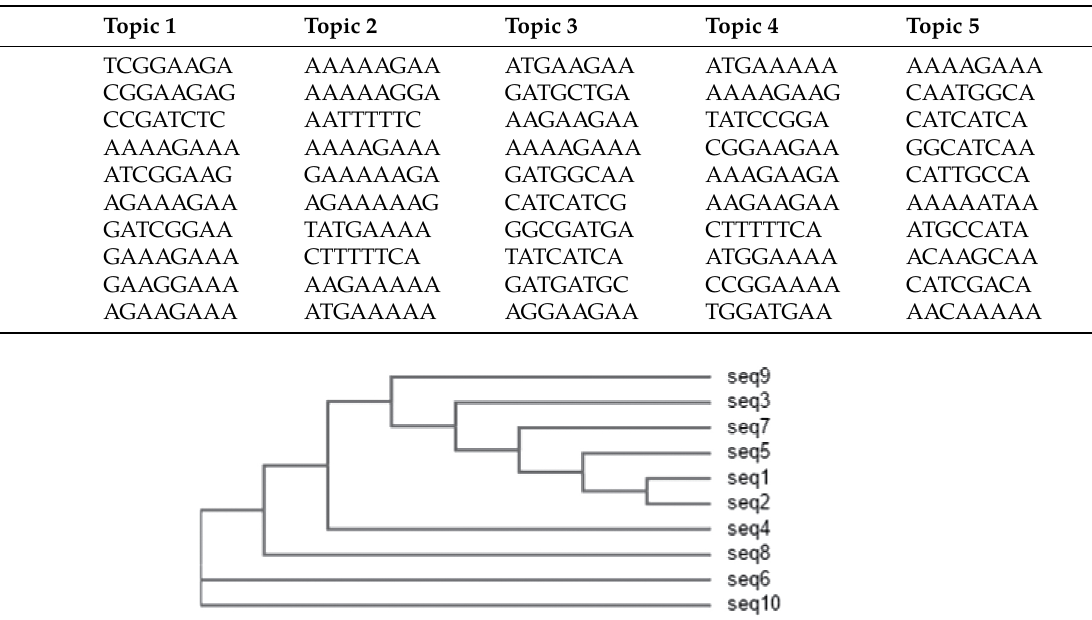
Figure 6: Phylogenetic tree of sequences in the topic 1.